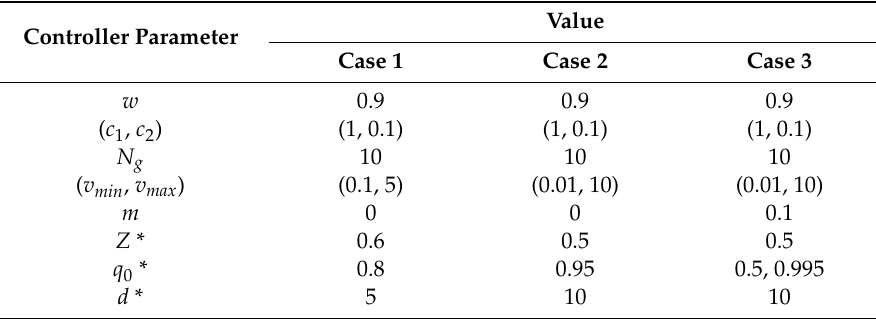
Table 3. Controller parameters of algorithms in three case